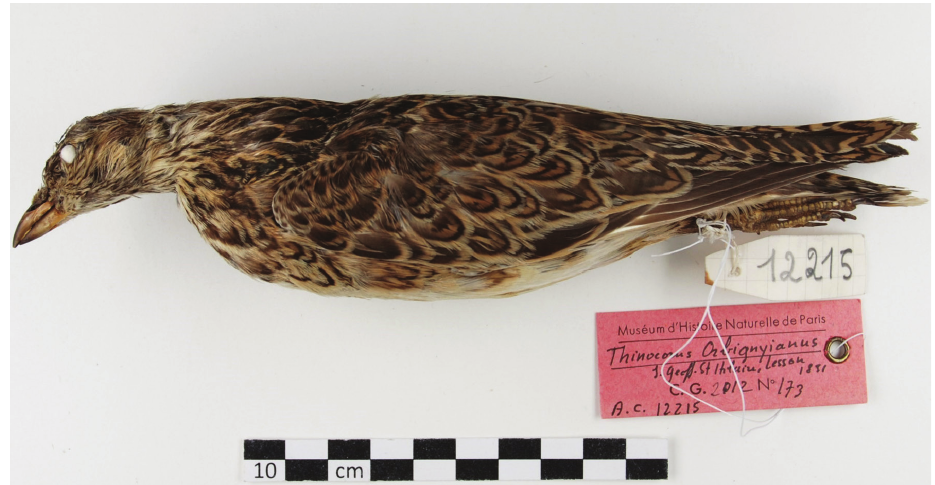
Figure 5: Thinocorus Orbignyianus (femalle), collected by Gay in Santiago, Muséum d’Histoire naturelle